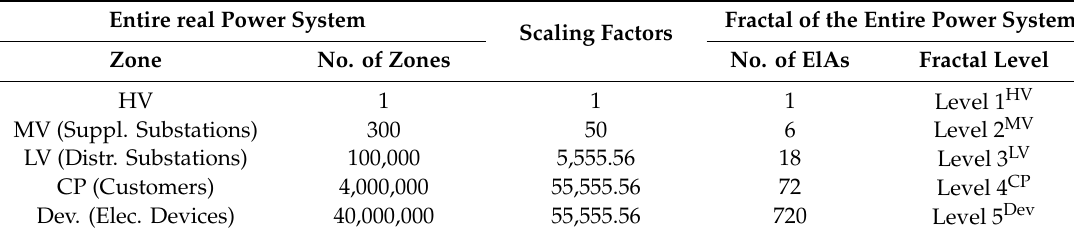
Table 2. The fractal structure of smart grids based on different fractal levels.